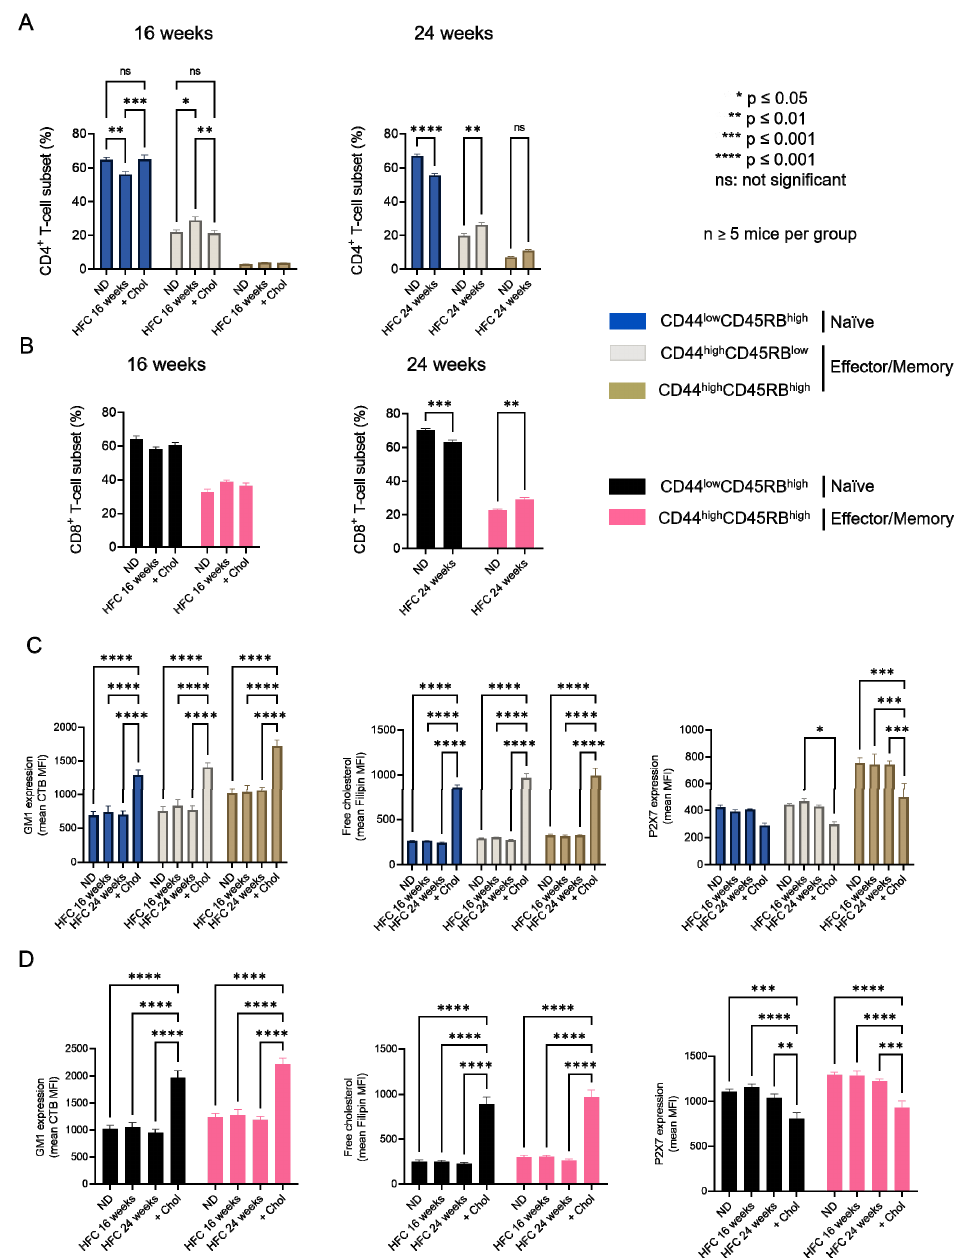
Figure 5. Impact of diet-induced hypercholesterolemia on the proportion of CD4 + and CD8 + T-cell subsets in B6 mice . Percentage of CD4 + ( A ) and CD8 + ( B ) T-cell subsets quantified by flow cytometry for mice fed either a normal diet (ND) or a high-fat diet (HFC) maintained for 16 (left panel) or 24 weeks (right panel). Splenocytes from mice fed a normal diet were treated with MBCD/Chol complexes (+Chol) ex vivo as a positive control for cholesterol enrichment. ( C,D ) Plasma membrane levels of GM1, cholesterol, and P2X7 quantified by flow cytometry in splenocytes from mice fed either a normal diet or a high-fat diet maintained for 16 (left panel) or 24 weeks (right panel). Results are pre- sented as the mean MFI values for GM1, cholesterol, and P2X7 among CD44 low CD45RB high naïve and CD44 high CD45RB low or CD44 high CD45RB high effector/memory CD4 + ( C ) and CD8 + ( D ) T-cell sub- sets. Data are expressed as the mean of percentages ( ± SEM, n ≥ 5 mice). Asterisks denote statistically significant differences: * p ≤ 0.05, ** p ≤ 0.01, *** p ≤ 0.001, **** p ≤ 0.0001, ns: not